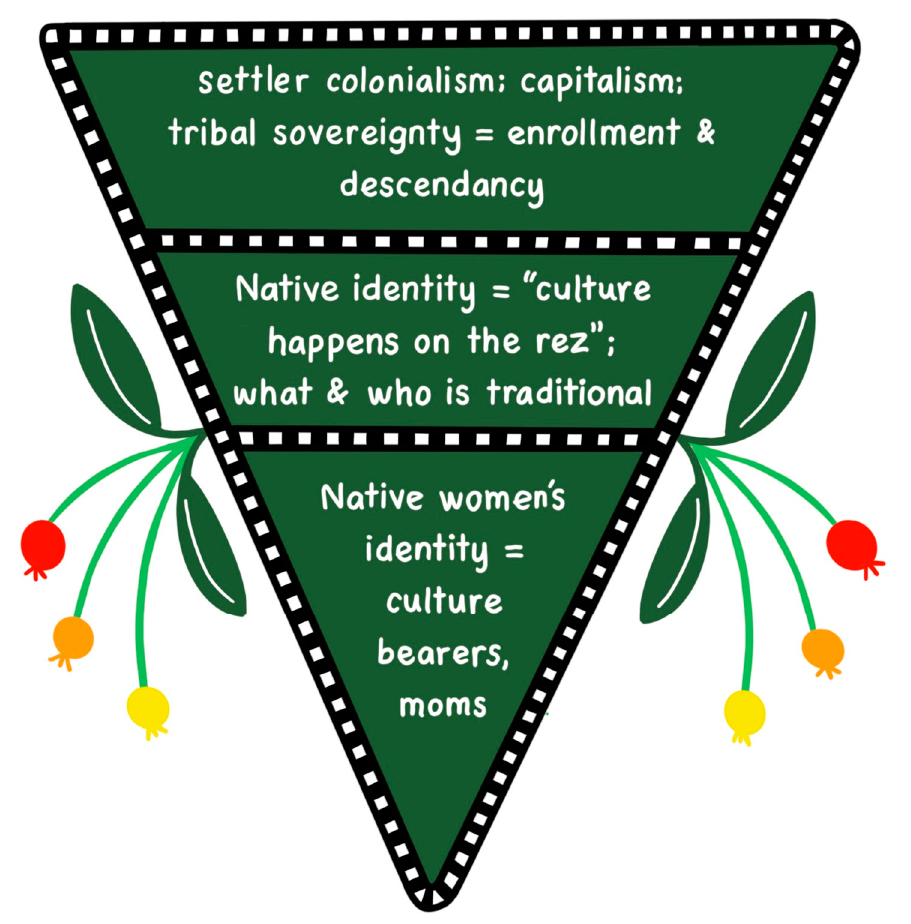
Figure 12. A visual cascade of narrowing boundaries and definitions of identity. See I.D. 12 in